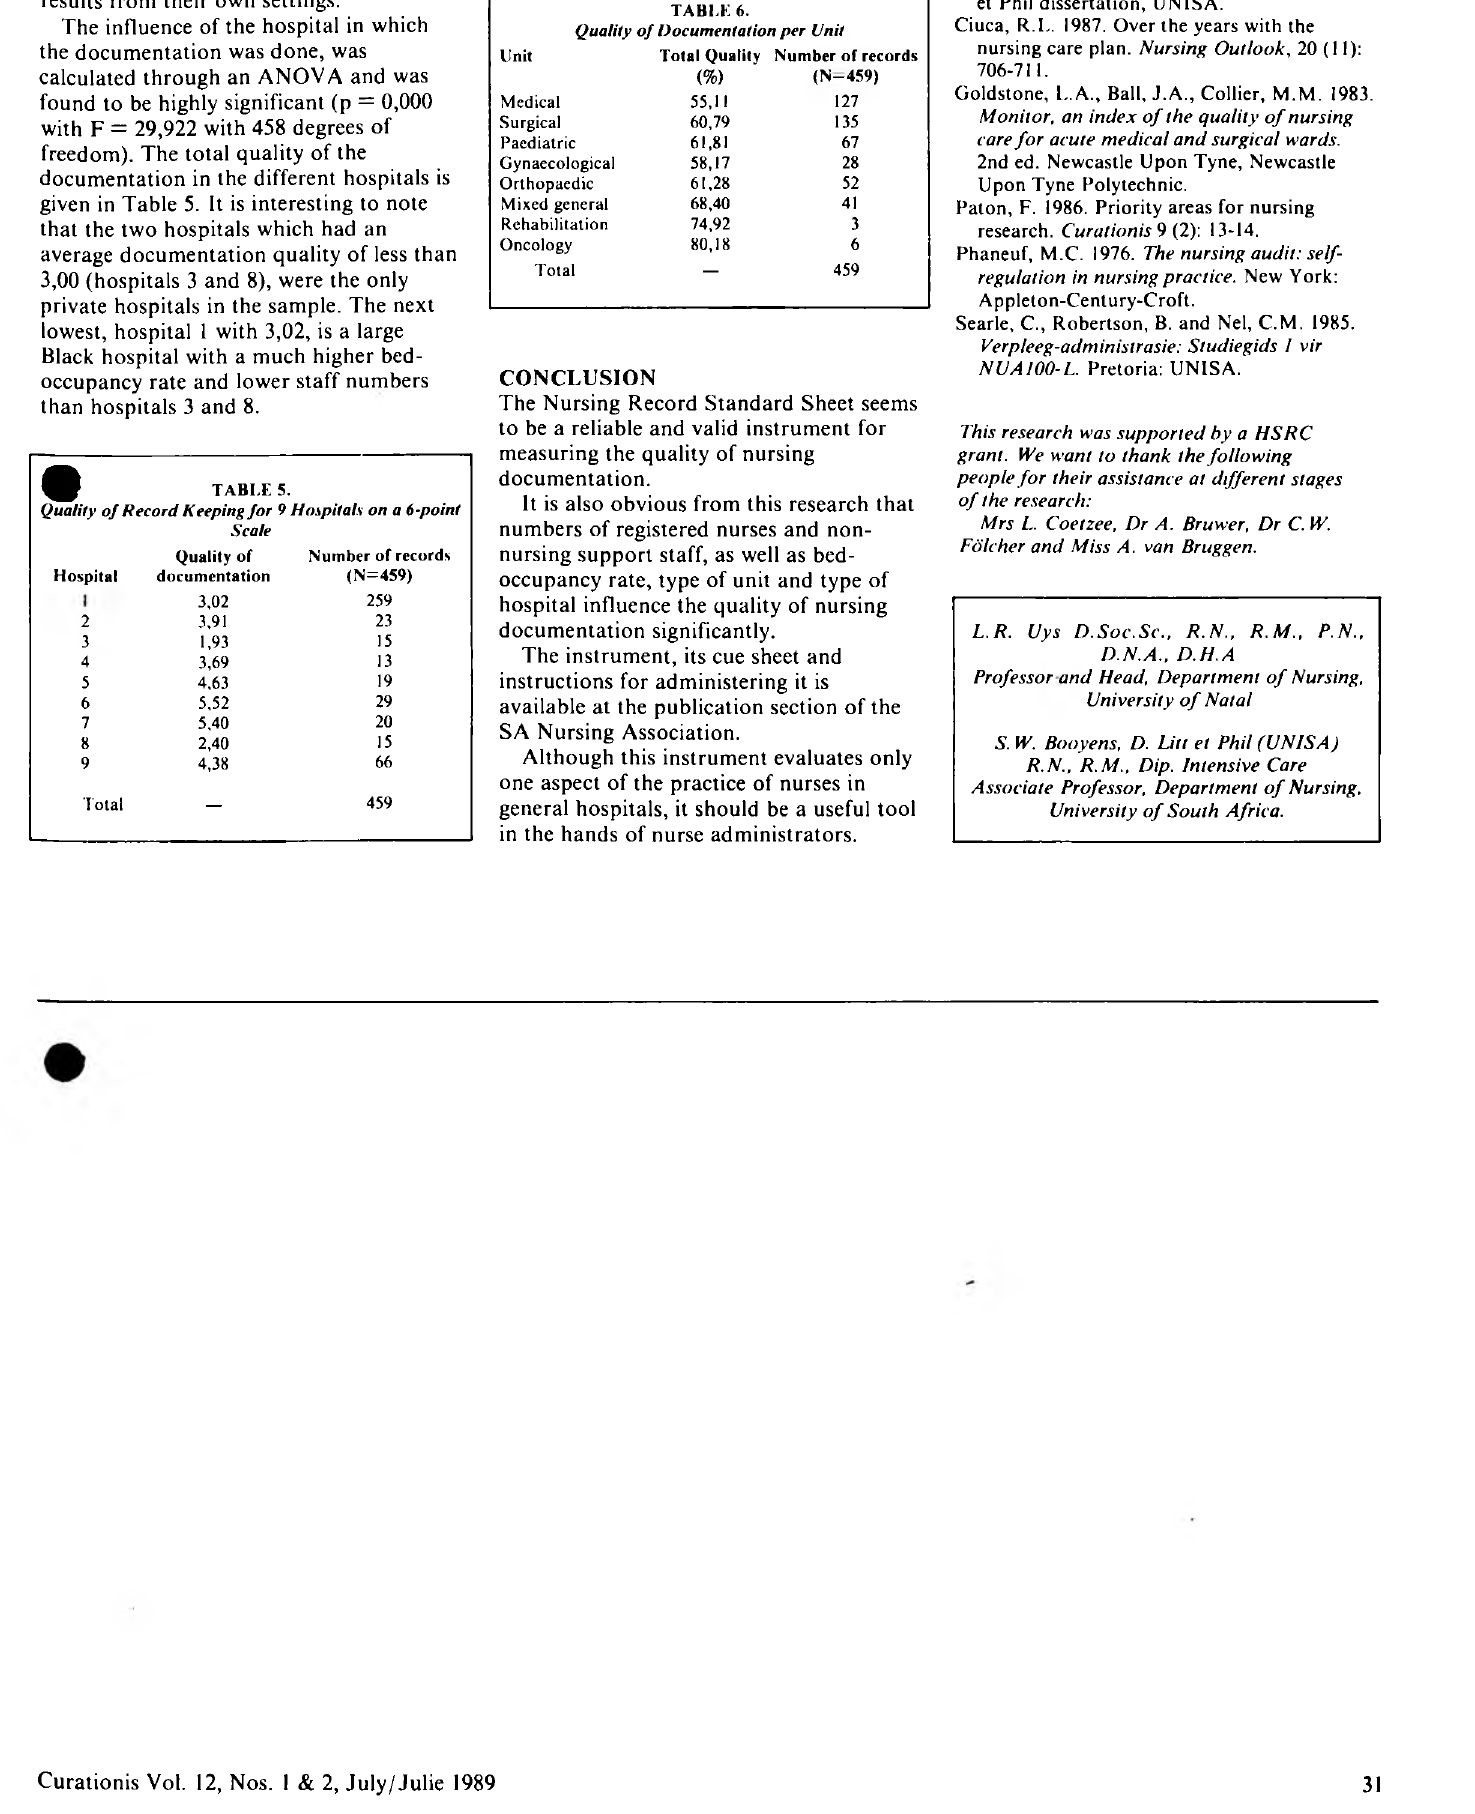
TABLE 5. Quality of Record Keeping for 9 Hospitals on a 6-point Scale Quality